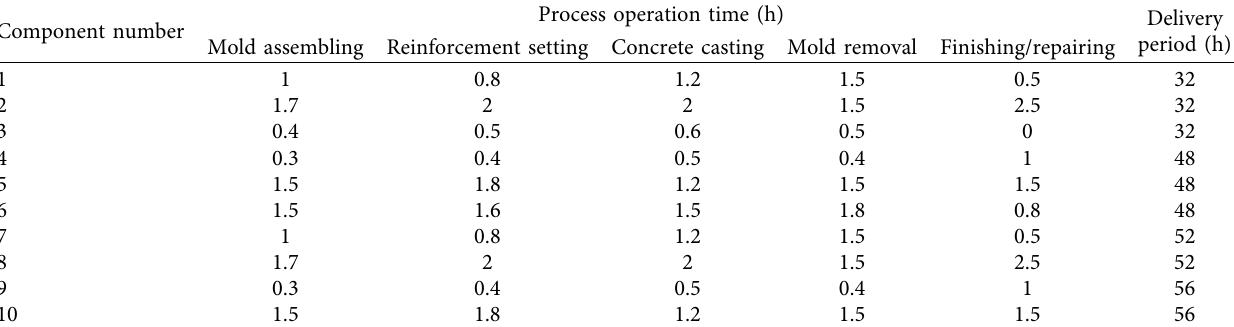
Table 4: Operating time and delivery deadline of each process for 10 components.